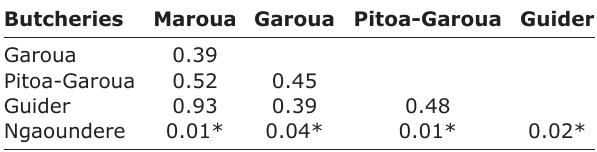
Table-4: The SPC load comparisons among the butcheries.